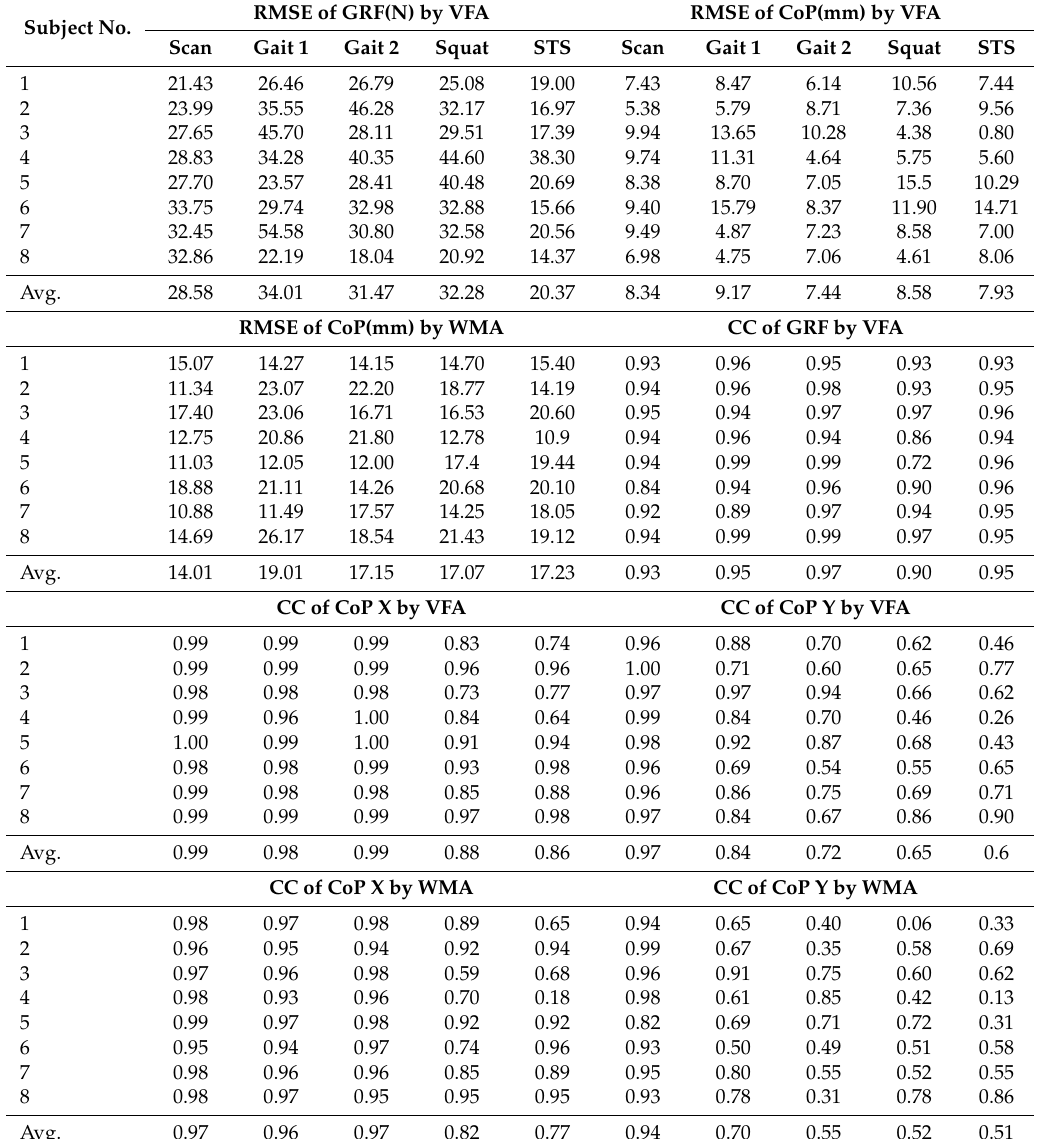
Table 2. The RMSE (Root Mean Square Error) of the estimated GRF and the calibrated CoP by VFA and correlation coefficient (CC) of the estimated GRF and the calibrated CoP by VFA and WMA.